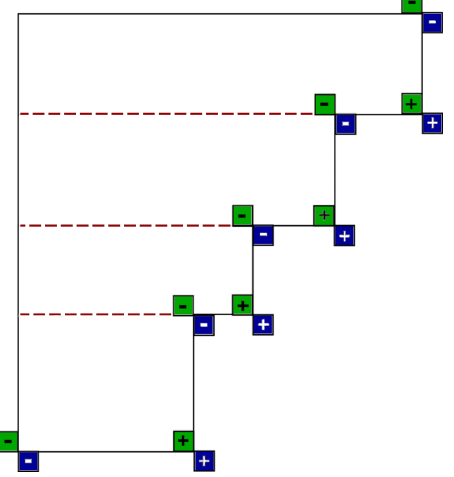
Figure 3: Representation of the integrand for general k . We divide the diagram into rectangles as indicated by the dashed red lines. Factors in the numerator correspond to a box at the bottom right corner of each rectangle and a box shifted by ω Factors in the denominator correspond to each allowed box that can be added to get a valid k + 1-instanton diagram and a box shifted by − ω factors with φ , while those in green have − φ k + 1